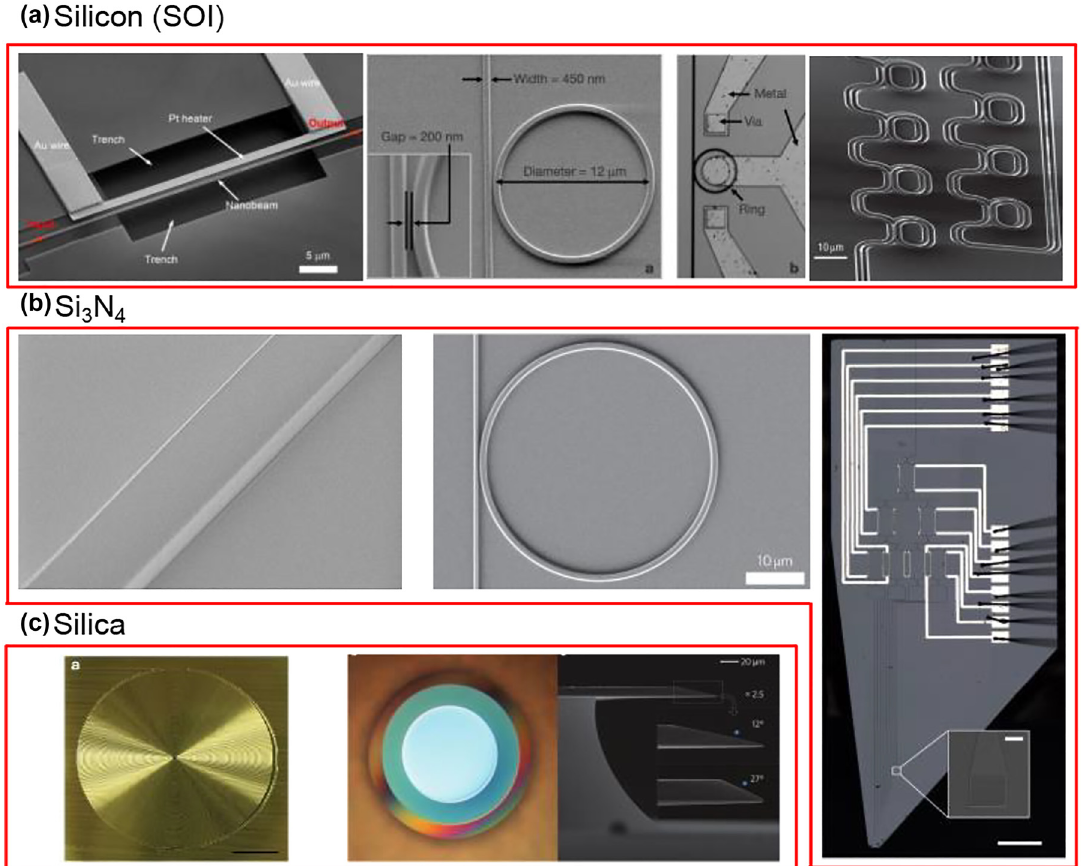
Figure 2: Typical devices of silicon-family materials. (a) Silicon: a single-resonance silicon nanobeam filter [22]; a micrometer-scale silicon electro-optic modulator [23]; an on-chip silicon waveguides and cascaded microring resonators based optical delay line [24]. (b) Silicon nitride: scanning